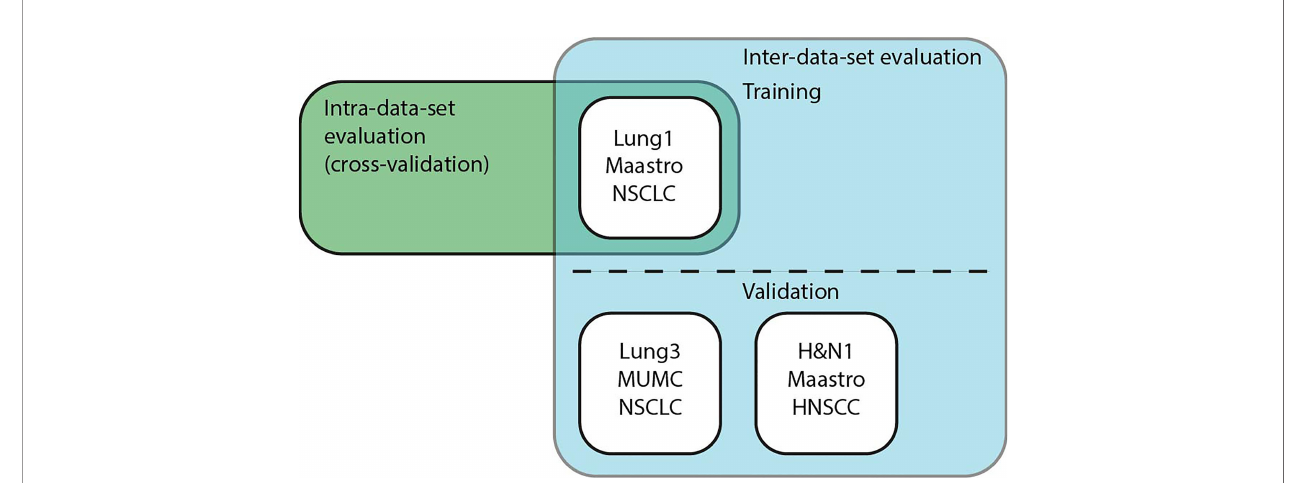
FIGURE 5 | Schematic overview of the experiments. Intra-data-set uses Lung1 for training and testing in a cross-validation setup. For Inter-dataset evaluation, methods were trained on Lung1 and evaluated on Lung3 or H&N1.